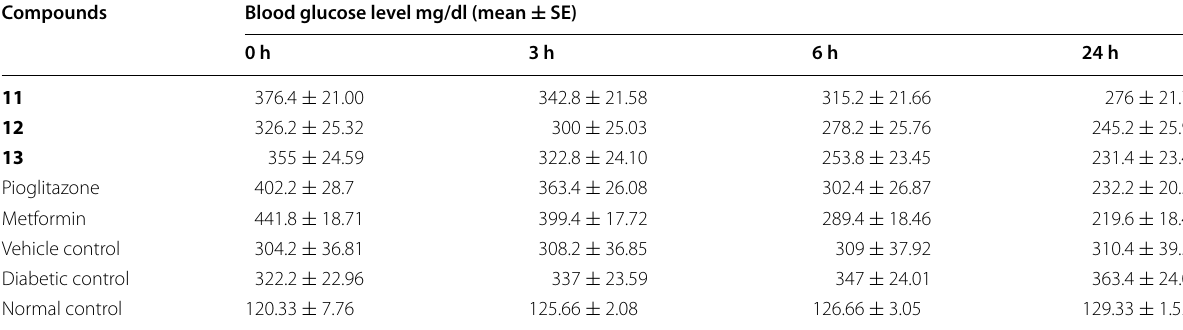
Vehicle control Diabetic control Normal